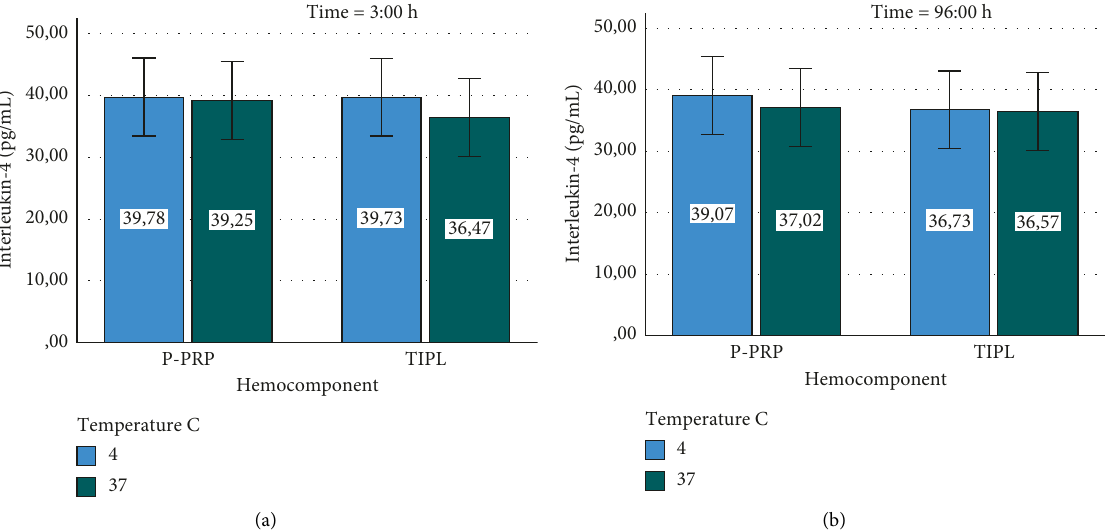
Figure 6: Mean ± sd interleukin-4 concentration in hemocomponents affected by time and temperature. (a) Interleukin-4 at 3h. (b) Interleukin- 4 at 96h.